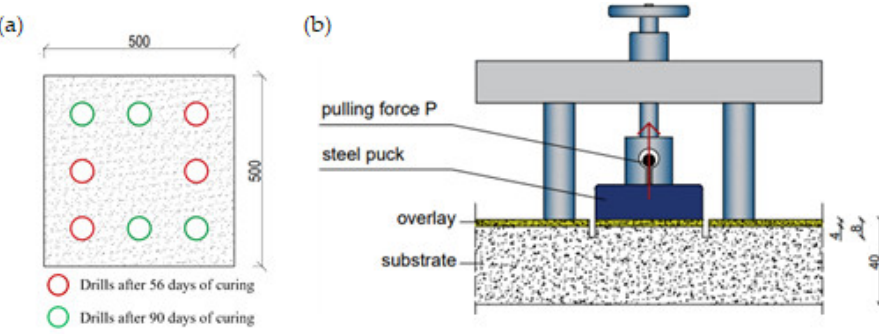
Figure 2. Pull-off test: ( a ) pull-off disc arrangement diagram; and ( b ) pull-off test.